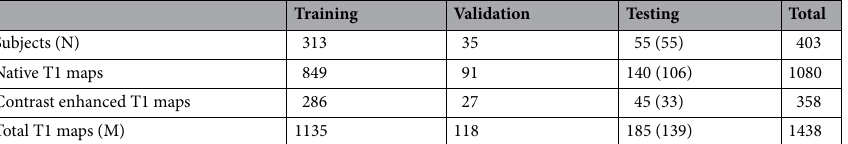
Table 1. Overview of the complete dataset, the (numbers) in brackets denotes the number for midventricular and basal slices only that are used as test dataset in this